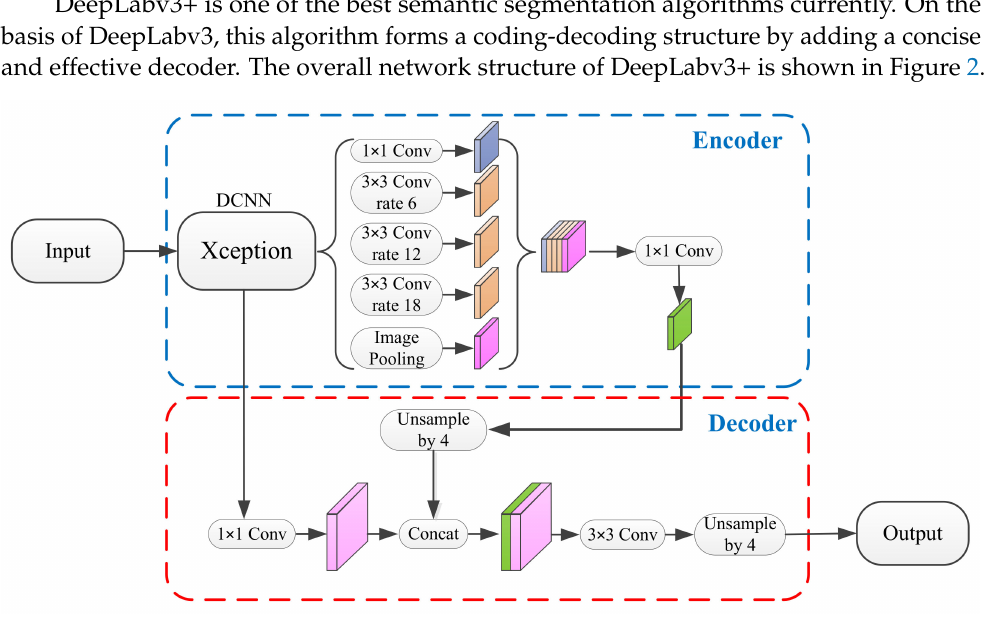
Figure 2. DeepLabv3+ network